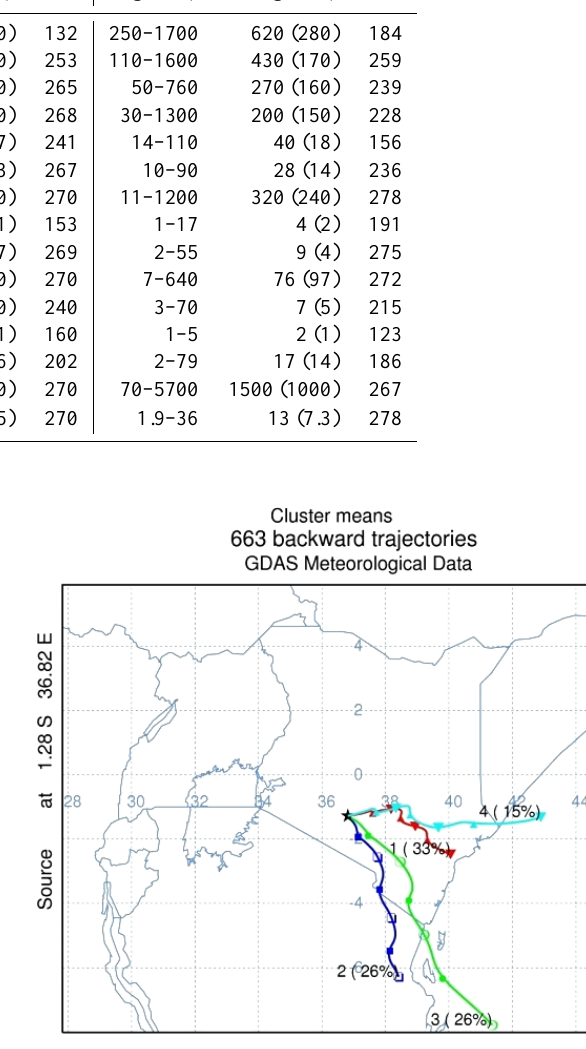
Figure 3. Clustered 72h back trajectories ending in Nairobi at 100m height above the ground for the period, 22 May 2008 to 30 March 2010. Calculated back trajectories originate principally from the southeast (trajectories 2 and 3) and east (trajectories 1 and